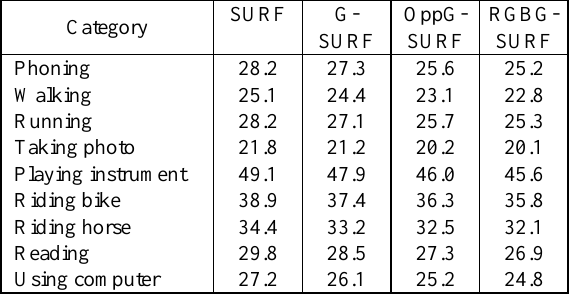
Table 3. False acceptance rates for nine action categories